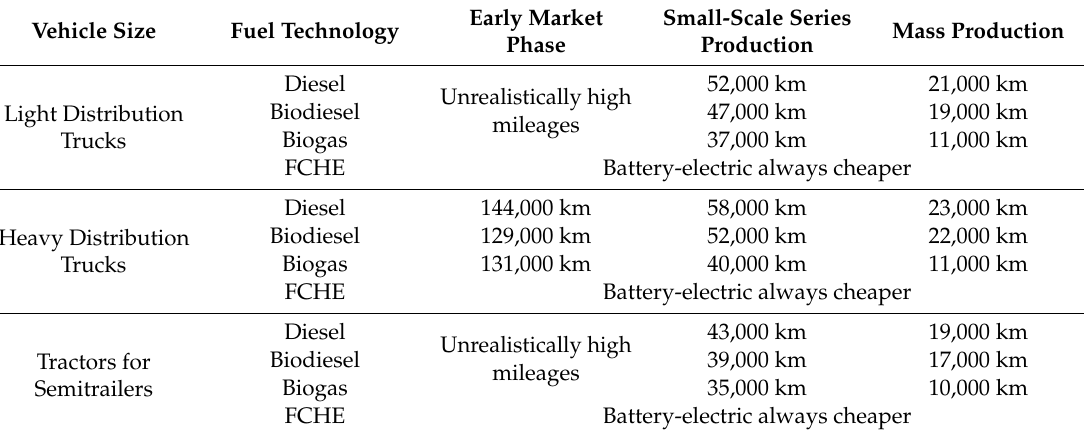
Table 6. Annual mileages (km) at which battery-electric vehicles (utilizing fast charging) are calculated to achieve cost-parity with other technologies. Rounded to the nearest thousand